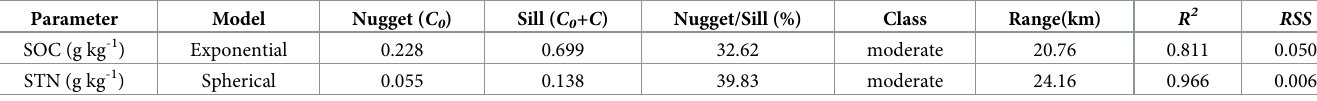
Table 2. Parameters for the SOC and STN semivariogram